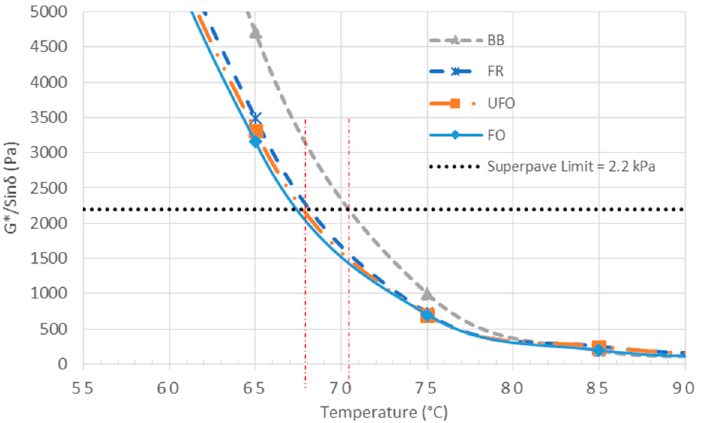
Figure 8. Decrement in high temperature performance grade of unaged asphalt binders. Appl. Sci. 2018 , 8 , x FOR PEER REVIEW